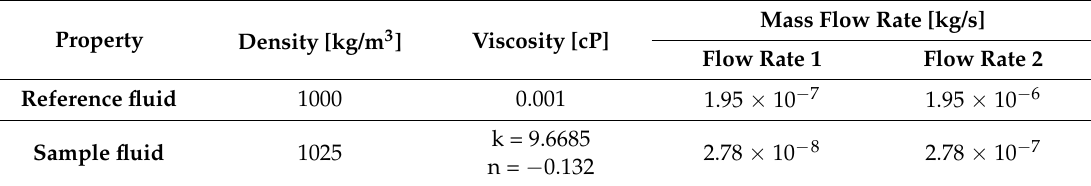
Table 1. Numerical conditions of the reference and sample